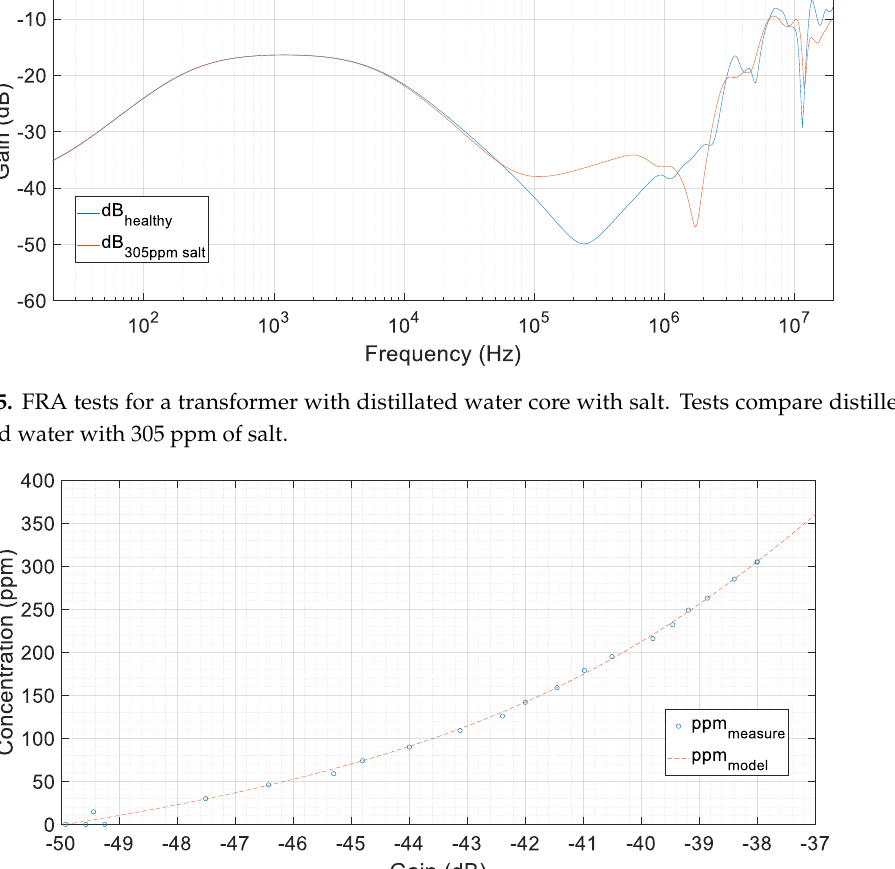
Figure 16. Measures of the minimum value of gains in the range of 100 kHz up to 500 kHz and the fitted curve.